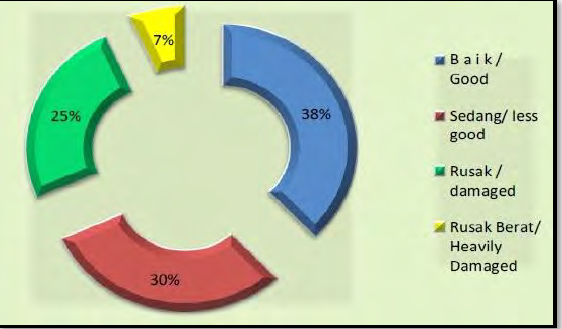
Figure 2. State Road Surface Condition by Surface in